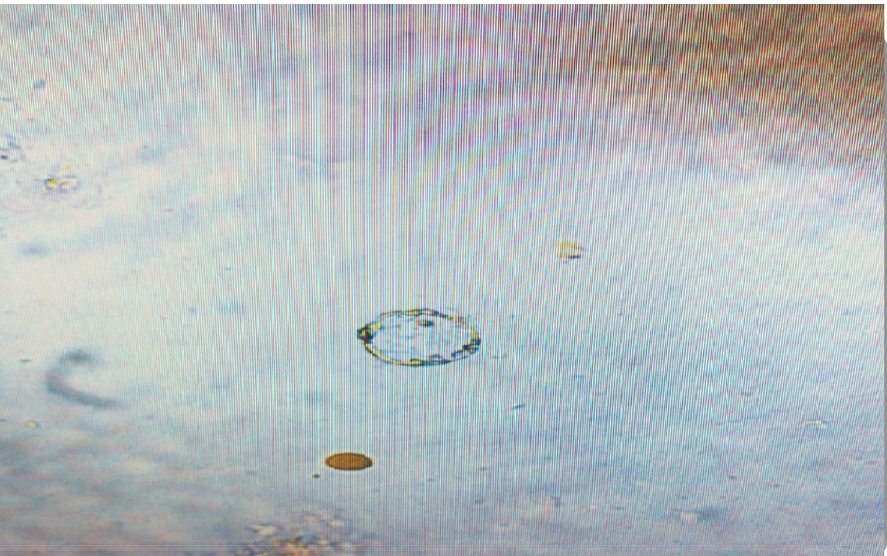
Figure 2. Cyst of Blastocystis in the faecal sample of fin and sperm whales (× 40 magnification) (photo by M.M.).